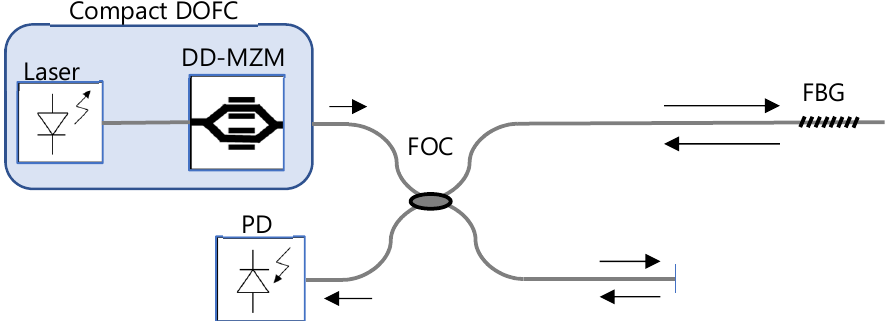
Figure 4. Basic scheme of the multiheterodyne dispersion interferometer for interrogating a fiber Bragg grating (FBG). DOFC, dual optical frequency comb; DD-MZM, dual-drive Mach–Zehnder modulator; FOC, fiber optic coupler/splitter; PD, photo-detector. The arrows indicate the direction of propagation of the light .